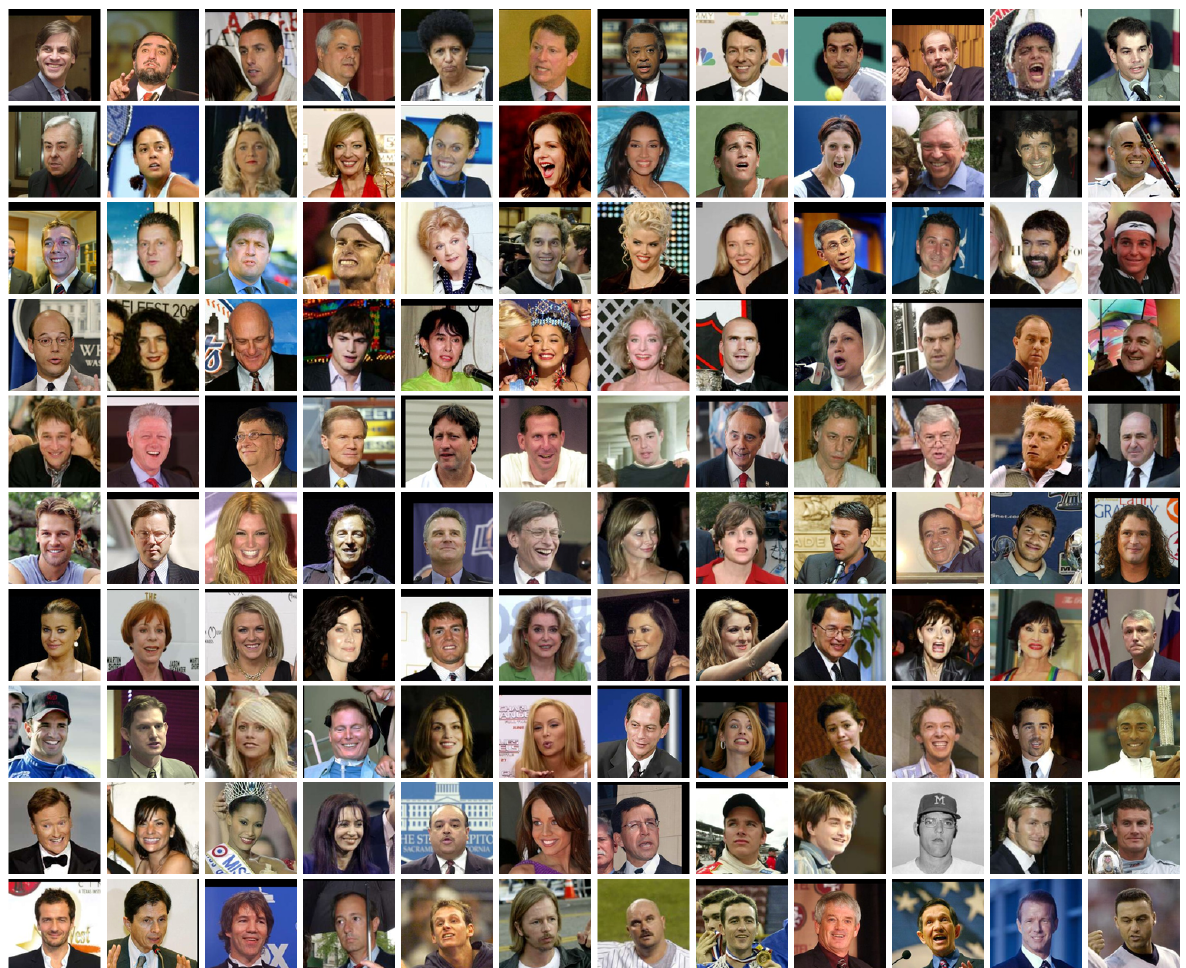
Figure 2. The montage of selected SRC frames (from LFW database) for face